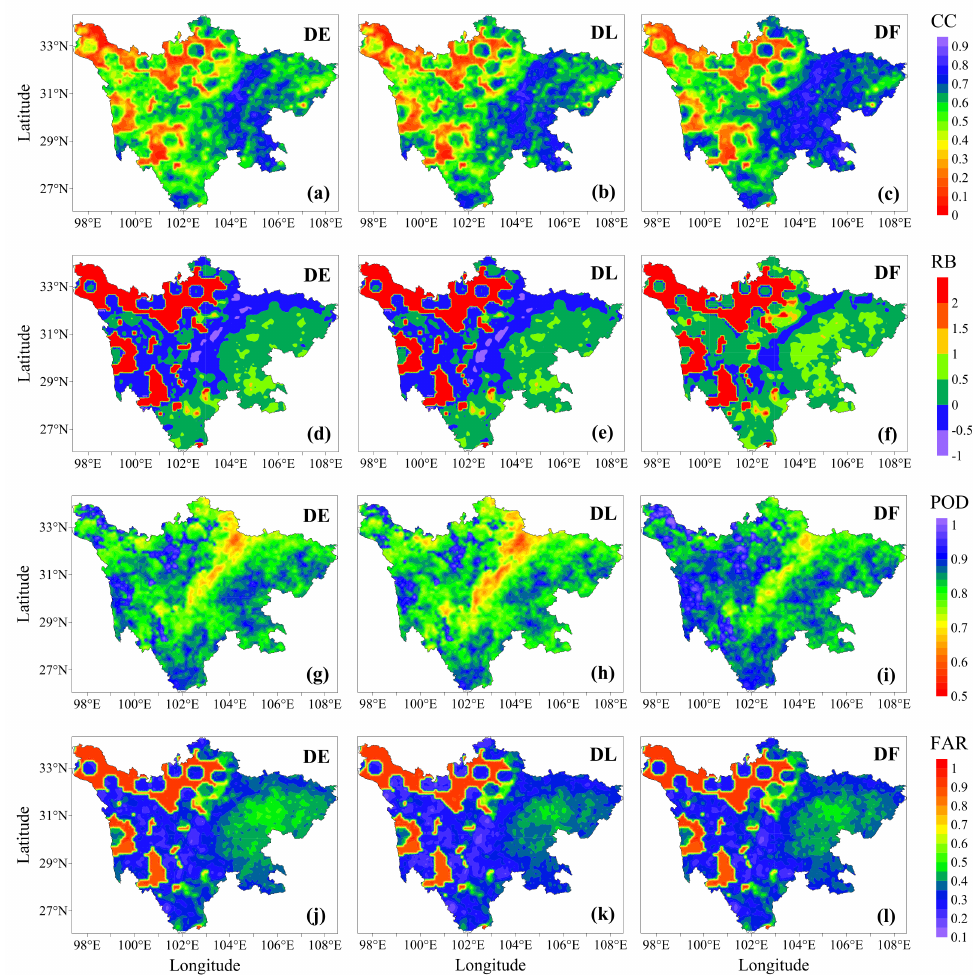
Figure 3. Spatial distributions of the statistical metrics for the IMERG-DE (left column), DL (middle column), and DF (right column): ( a – c ) CC, ( d – f ) RB, ( g – i ) POD, ( j – l )